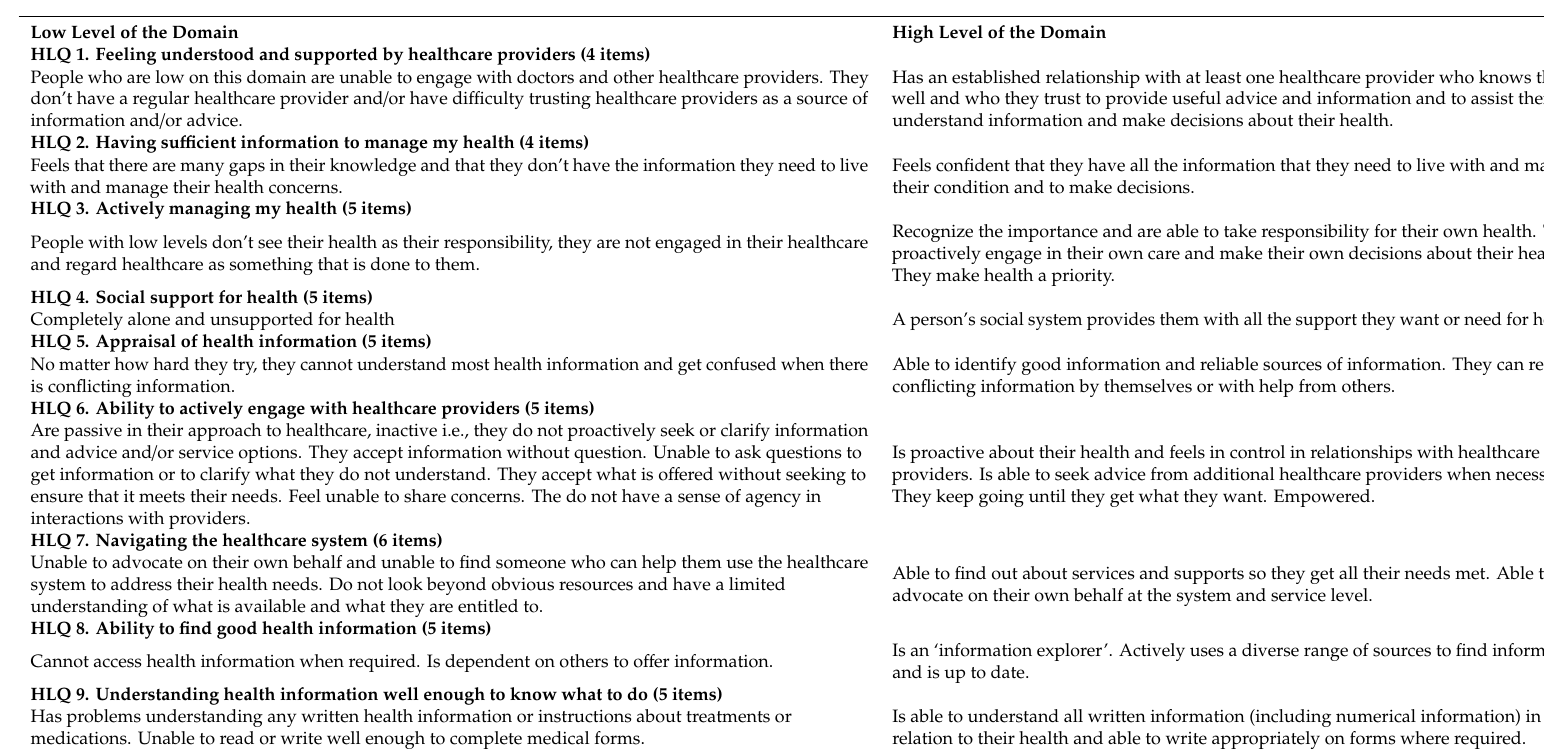
Table 1. List of all nine health literacy questionnaire (HLQ) domains with a description of respondent characteristics with low and high levels of the particular domain. Low Level of the